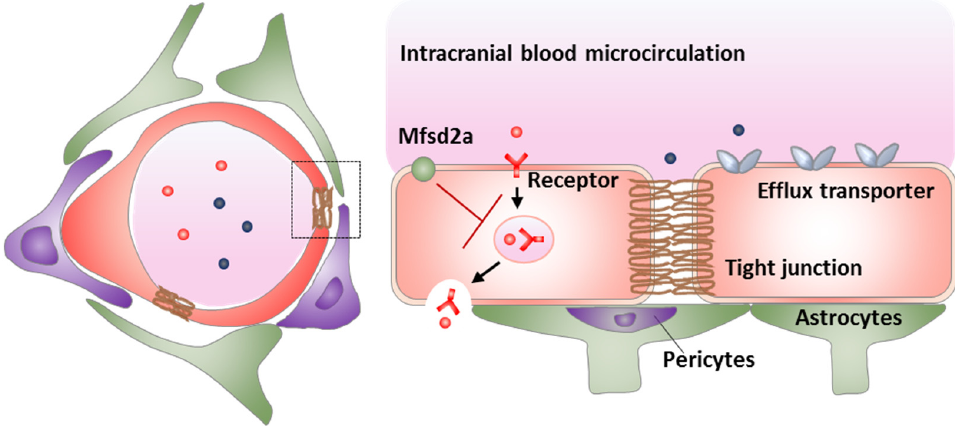
Figure 1. The neurovascular unit ( left ) and the mechanisms of transport inhibition by the BBB ( right ).